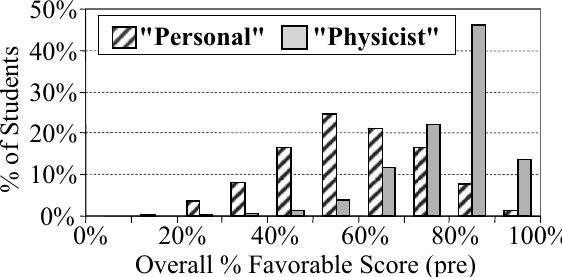
FIG. 3. “Personal” and “physicist” score distributions for Phys- ics I-Alg pre.